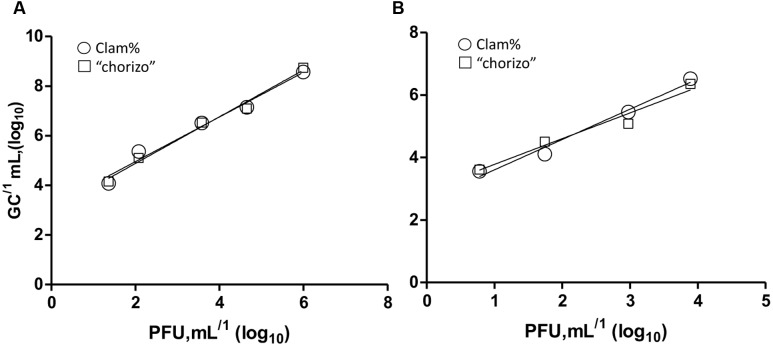
Mean equivalences correlation of PFU and GCs in 10-fold dilutions of HAdV-2
(A) and vMC0 (B). Balls and squares represent clam and “chorizo” samples, respectively. The R2 values were 0.92 and 0.99 for HAdV-2 and 0.96 and 0.96 for vMCo in clam and “chorizo” samples, respectively.